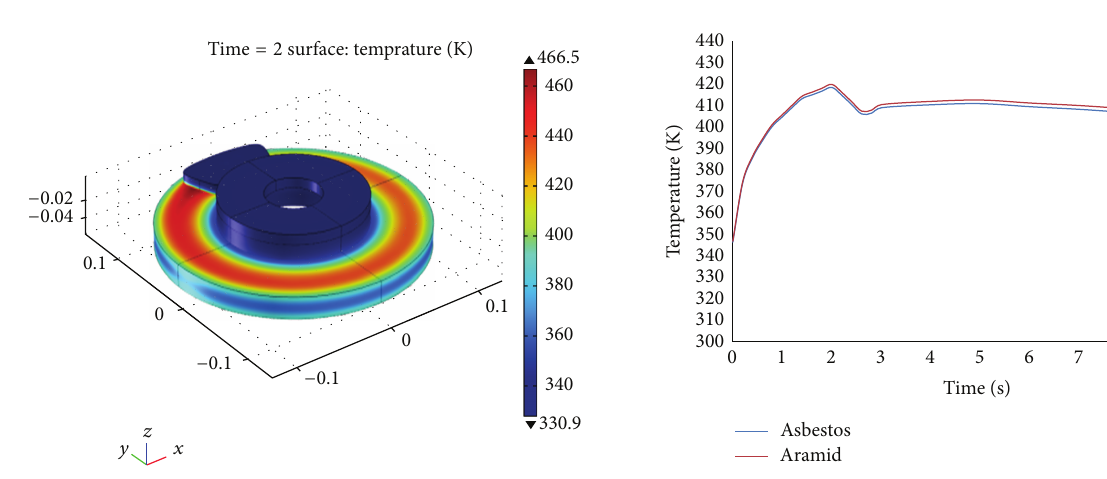
Figure 7: Temperature distribution for GCI disc and aramid pad at 𝑡 = 2 seconds.